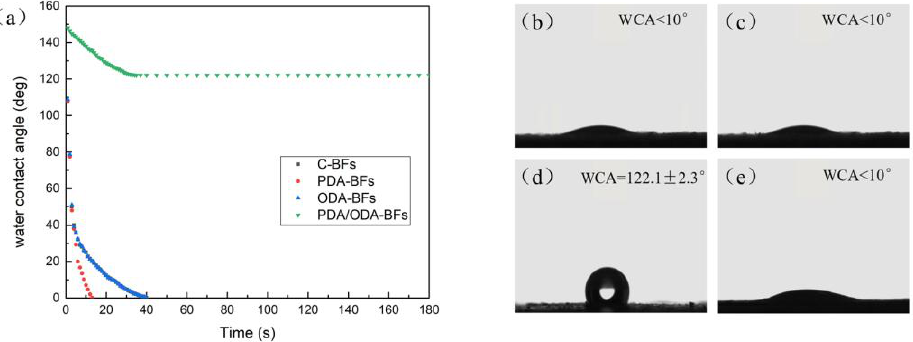
Figure 4. Hydrophobic performance characterization: ( a ) water contact angles as a function of time for BFs samples; and micrographs of 3 µ L deionized water droplets on the plane surfaces of: ( b ) C–BFs; ( c ) PDA–BFs; ( d ) PDA/ODA–BFs; and ( e ) ODA–BFs.